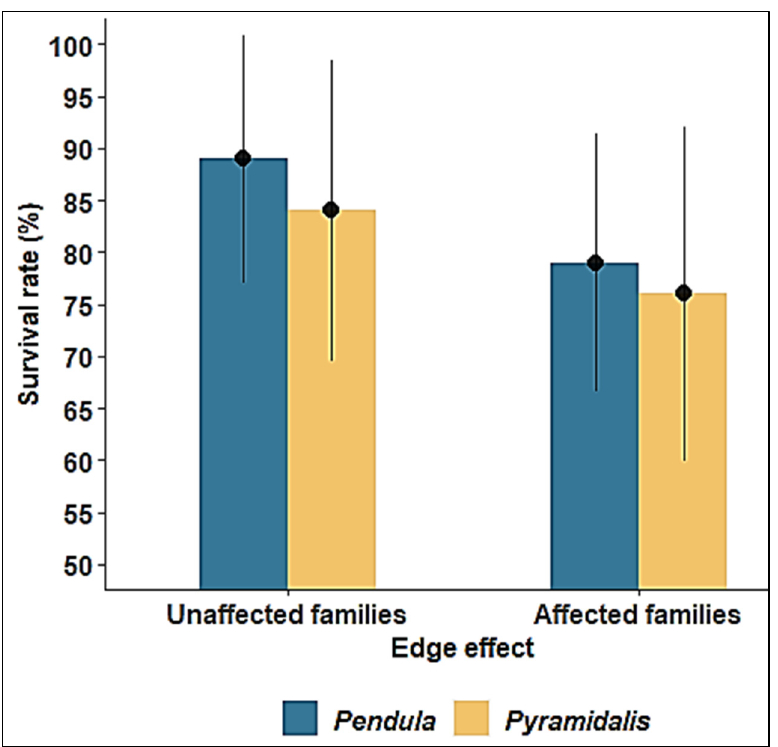
Figure 6. The influence of the edge effect on the survival rate of the two spruce varieties. The black vertical lines represent the standard deviations.